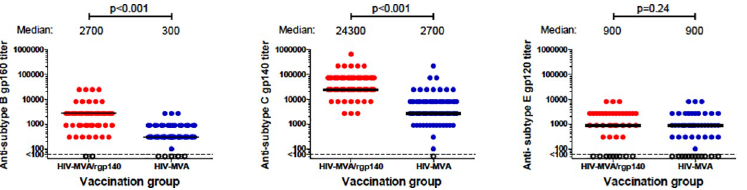
Fig 3. Binding antibody responses. (A) subtype B gp160, (B) subtype C gp140 and (C) subtype E gp120 antigen by the second randomization, in samples collected four weeks after the final vaccination in vaccine recipients only. Responders are shown by filled circles and non-responders are shown by open circles. The Wilcoxon rank-sum test was used for comparisons.